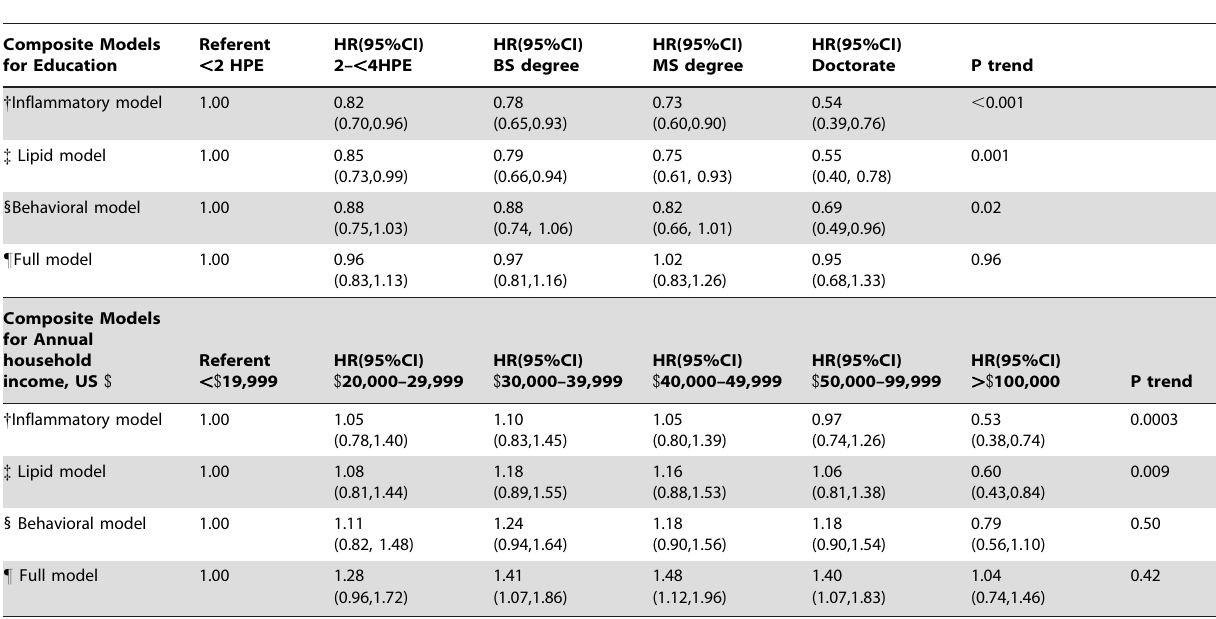
Table 4. Hazard ratios and Associated 95% CI for Incident Diabetes based on Education and Income.